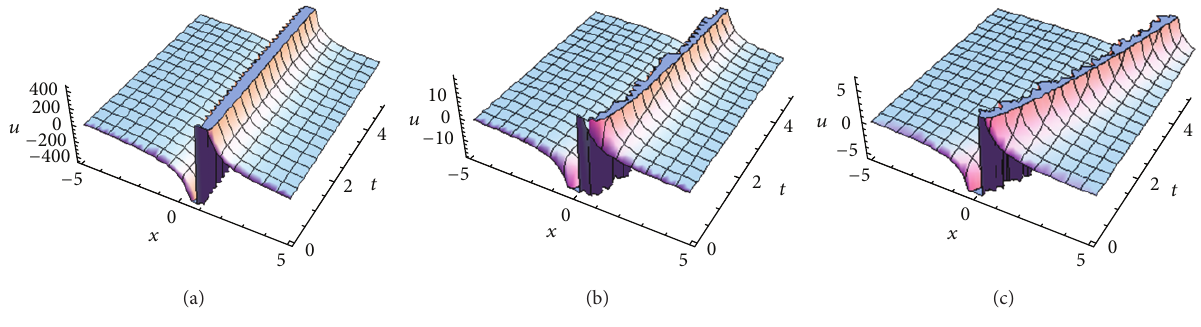
Figure 3: Graphics of the solution equation (52) corresponding to the values 𝛼 = 𝛽 = 0.01 , 𝛼 = 𝛽 = 0.25 , and 𝛼 = 𝛽 = 0.75 from left to right when 𝑘 = 𝑎 2 = 𝑏 0 = 0.1 , −5 < 𝑥 < 5 , and 0 < 𝑡 < 5 .